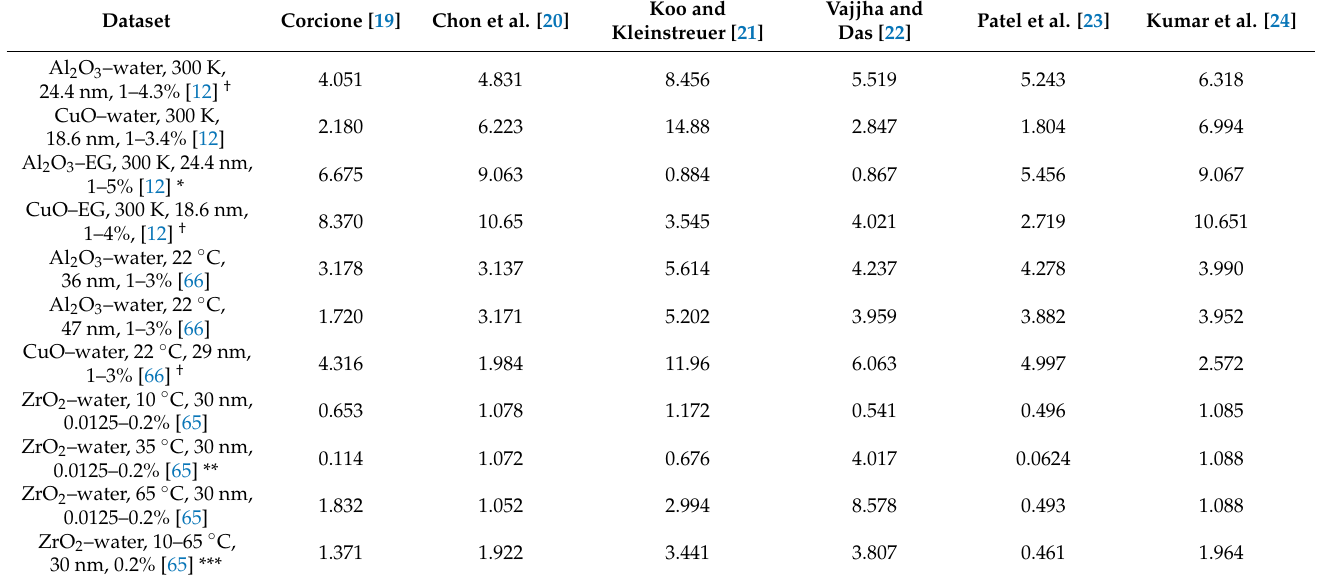
* Experimental data used in Figure 3; ** Experimental data used in Figure 4; *** Experimental data used in Figure 5; † Experimental data used in Figure